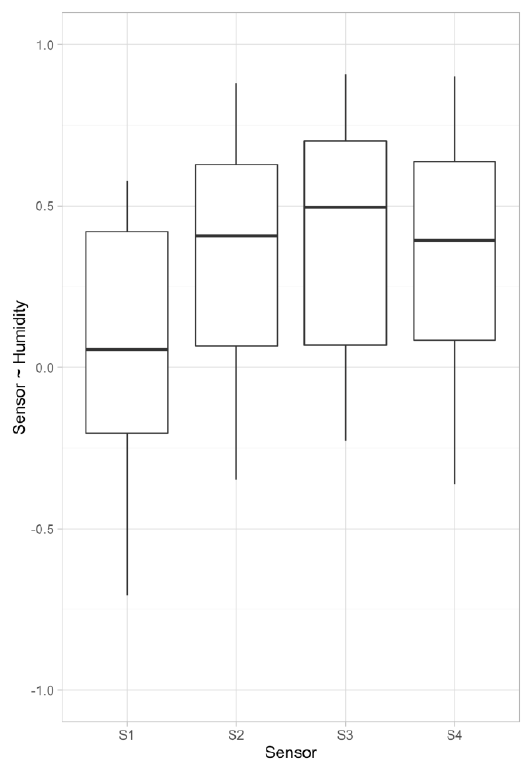
Figure 4. Mean correlation coefficient R between sensors and relative humidity. Upper and lower “hinges” correspond to first and third quartile, respectively, and whiskers indicate 95% confidence interval.